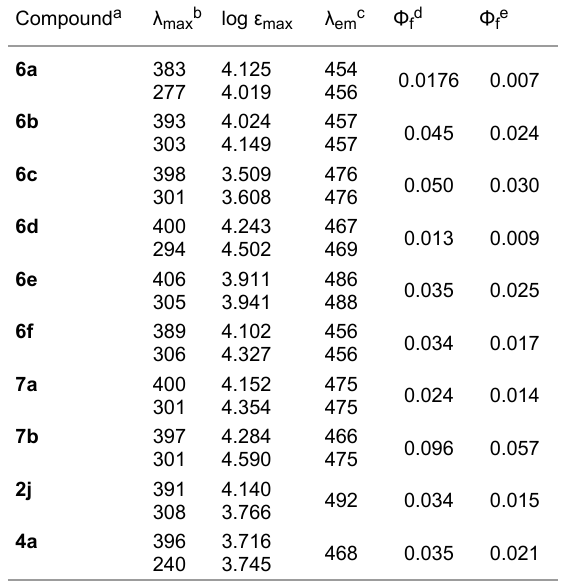
Table 2: The absorption and fluorescence of 6a – f , 7a , b , 2j and 4a . Compound